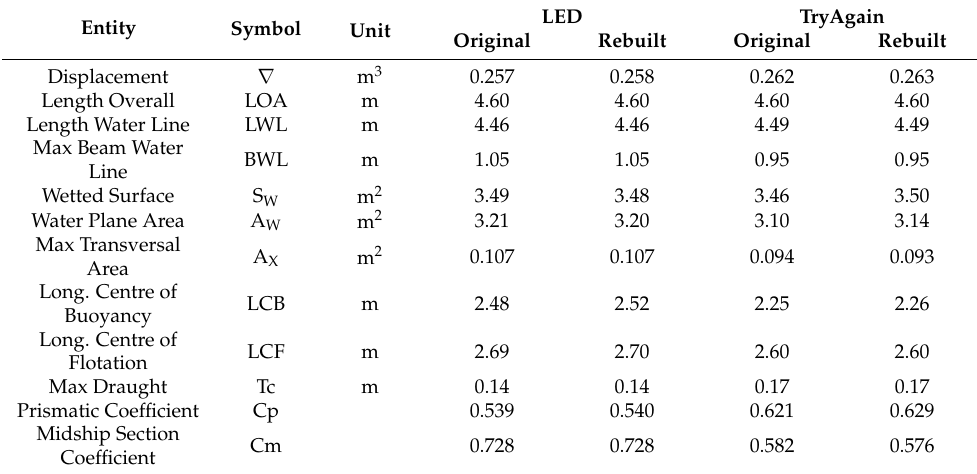
Table 1. Coefficients of the original and rebuild hulls.